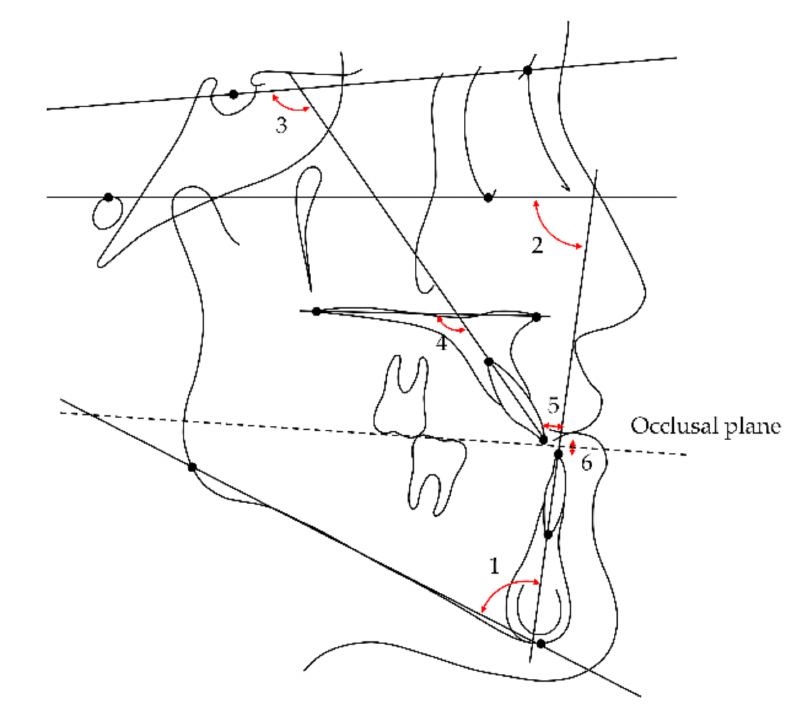
Figure 3. Dental cephalometric variables measured in this study (overjet and overbite were linear measurements whereas the other variables were angular measurements): 1, incisor mandibular plane angle (IMPA); 2, Frankfort-mandibular incisor angle (FMIA); 3, maxillary incisor to SN plane angle (U1 to SN); 4, maxillary incisor to palatal plane angle (U1 to PP); 5, overjet; 6,